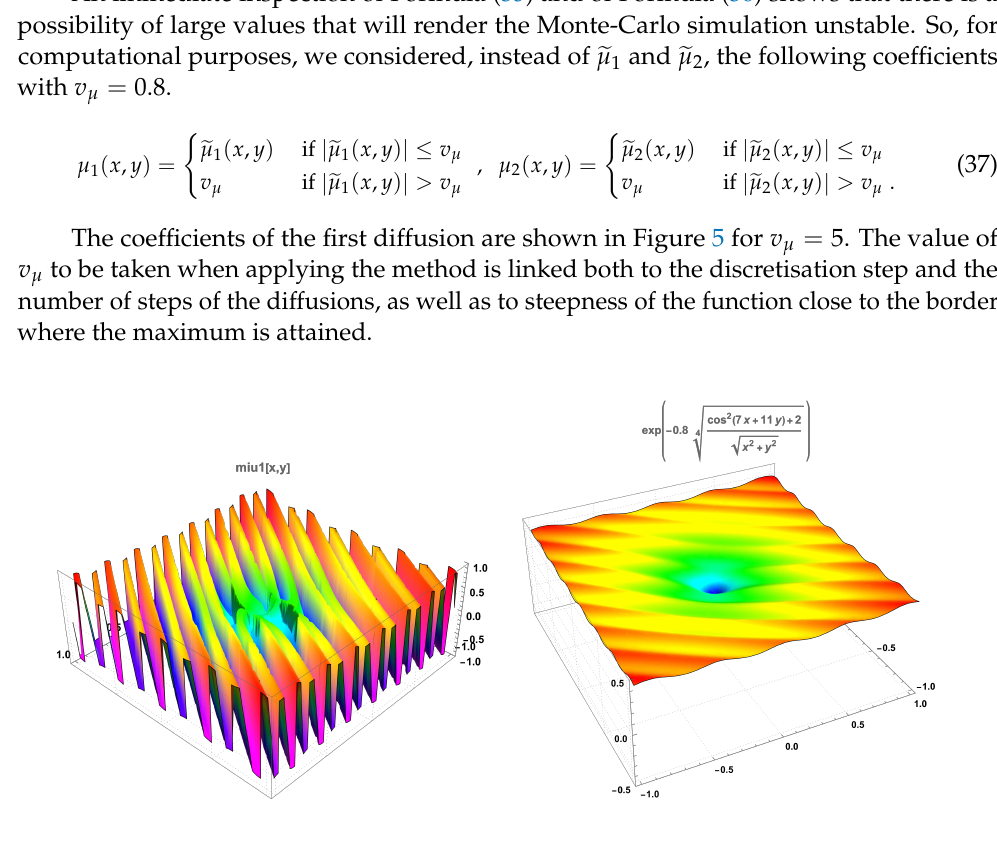
Figure 5. The coefficients of the first diffusion µ 1 and σ 1 .